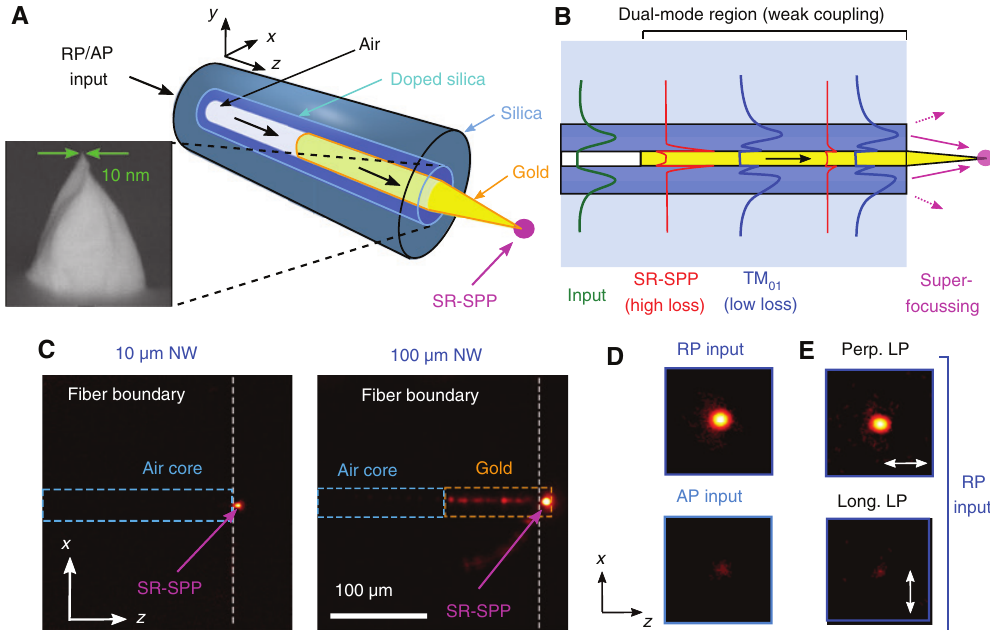
Figure 6: Nanobore fiber-based near-field probe consisting of a gold nanowire inside the fiber core with protruding gold nanotip. (A) Schematic of the monolithic near-field nanoprobe excited by either RP or AP mode. The magenta dot at the front of the tip indicates the intensity enhancement. The inset shows an SEM of a typical gold nanotip, with the sub-10 nm tip region highlighted in green. (B) Illustra- tion of the operating principle: the input core mode (dark green) excites two hybrid EMs (dual-mode region) that propagate in the gold- filled region. The SR-SPP mode has high loss and rapidly decays, so that the TM is the dominant mode at the fiber end-face. The RP field 01 on the gold surface is focused at the apex via the SR-SPP travelling down the tip; the field in the dielectric core diffracts into free space. (C) Microscopic image of side scattered light for an RP input state for a short (left) and long (right) nanowire inside the fiber. Highlighted are the empty (blue) and nanowire (orange) regions. The scattered light originating from the nanotip is indicated by magenta arrows. (D) Detailed view of the measured scattered light when the input is RP (top) or AP (bottom). (E) Also shown is the scattered light with a polar- izer inserted between sample and camera that is either axially (top) or transversely oriented (bottom). The orientation of the polarizer with respect to the nanotip axis is indicated by white double-headed arrows. All data are for λ = 650 nm. Adapted from Ref. [69]. Reprinted with permission from Ref. [70]. Copyright 2017 American Chemical